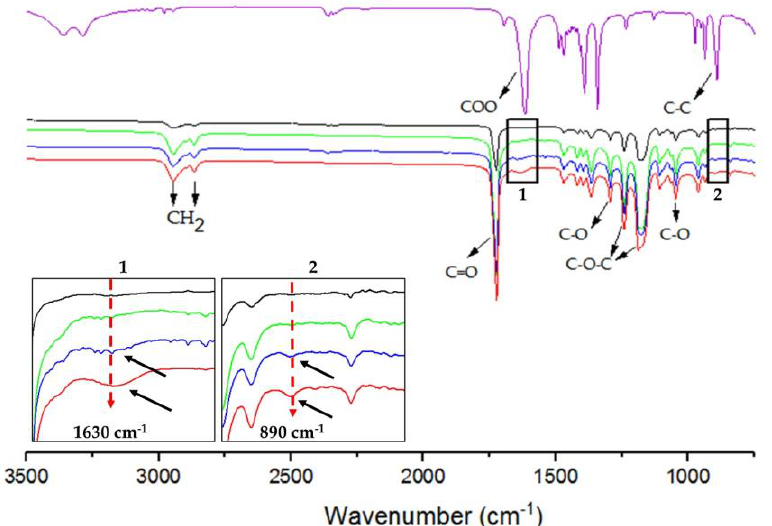
Figure 3. ATR/FT‑IR spectra of (purple) G, (black) P/G0‑EPnF, (green) P/G0.5‑EPnF, (blue) P/G1‑ EPnF, and (red) P/G2‑EPnF. Insets 1 and 2 show zoomed‑in images of the absorption bands of G at − 1 − 1 890 cm and 1630 cm for C‑C and the carboxylic groups in the P/G‑ EPnF